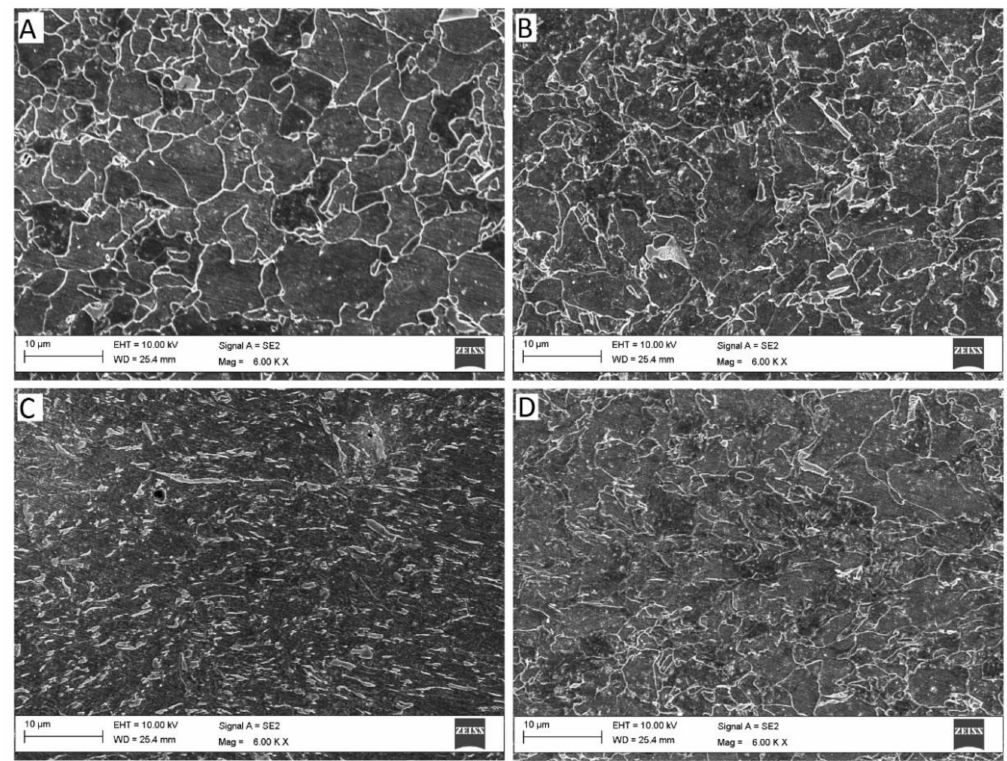
Figure 15. SEM images from high heat input (t 8/5 = 20 s) weld HAZ for steel S700MC-1. ( A – D ) are locations established in Figure 13.